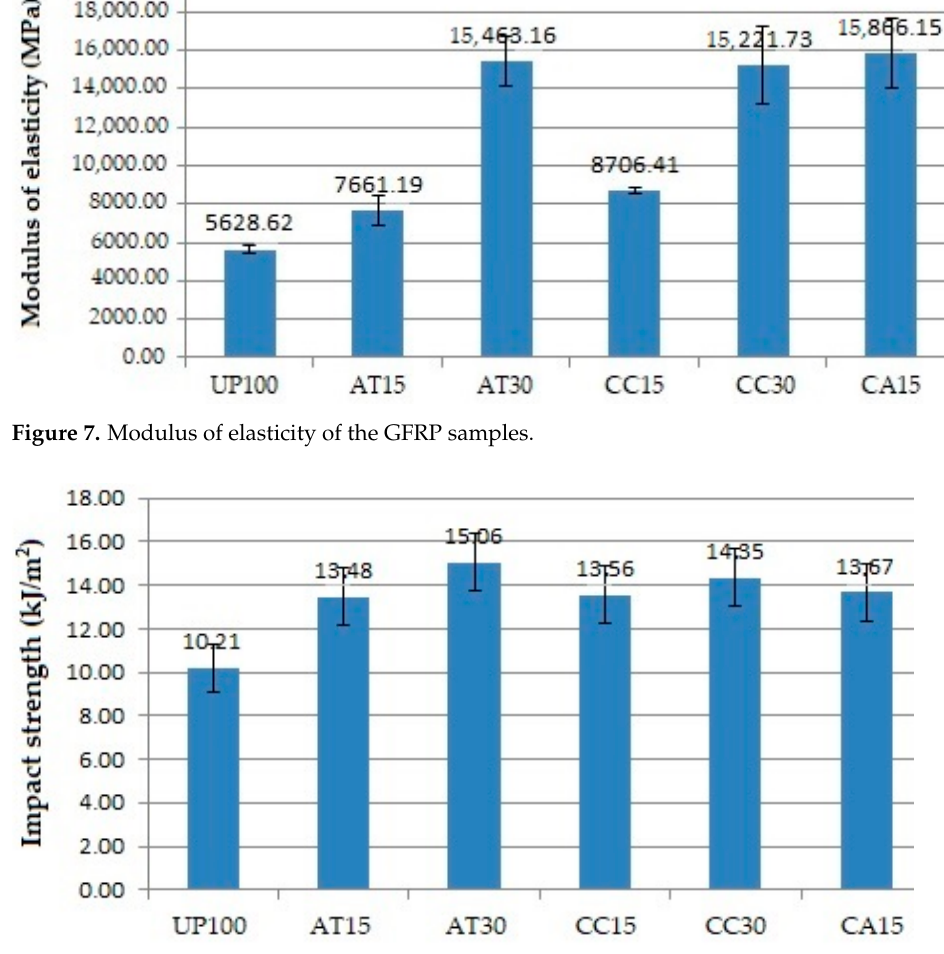
Figure 8. Impact strength of the GFRP samples.